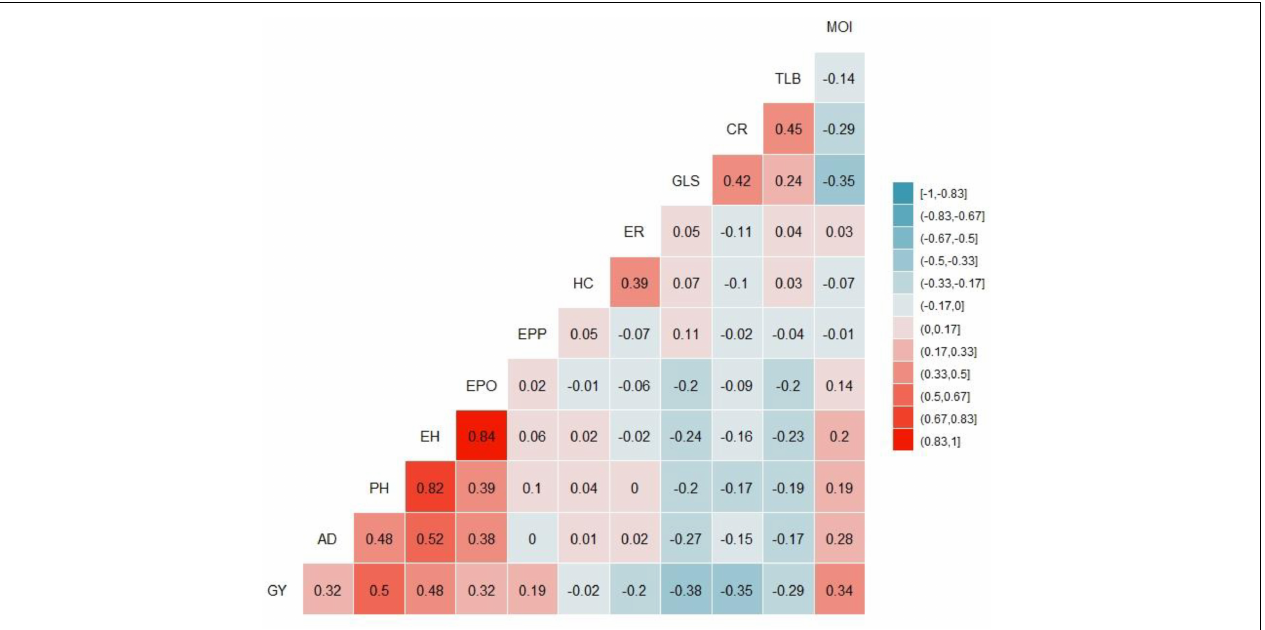
FIGURE 2 | Phenotypic correlations among 12 traits evaluated in four environments. The correlation level is color-coded according to the color key plotted on the extreme right. Correlations with > 0.12, and > 0.15 were significant at 0.05 and 0.01 levels, respectively. GY, grain yield; AD, days to anthesis; PH , plant height; EH , ear height; EPO , ear position; EPP , number of ears per plant; HC, husk cover; GLS, gray leaf spot; TLB, Turcicum leaf blight; CR , corn rust; MOI , grain moisture